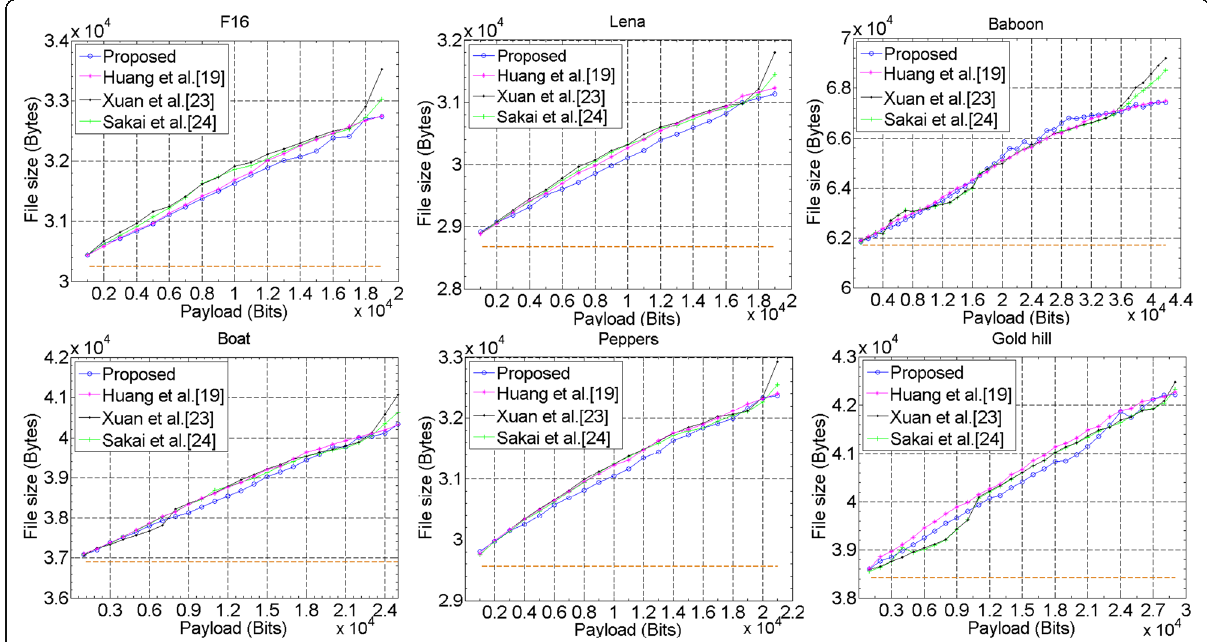
Fig. 7 File size comparison of the proposed scheme on six different images using four different